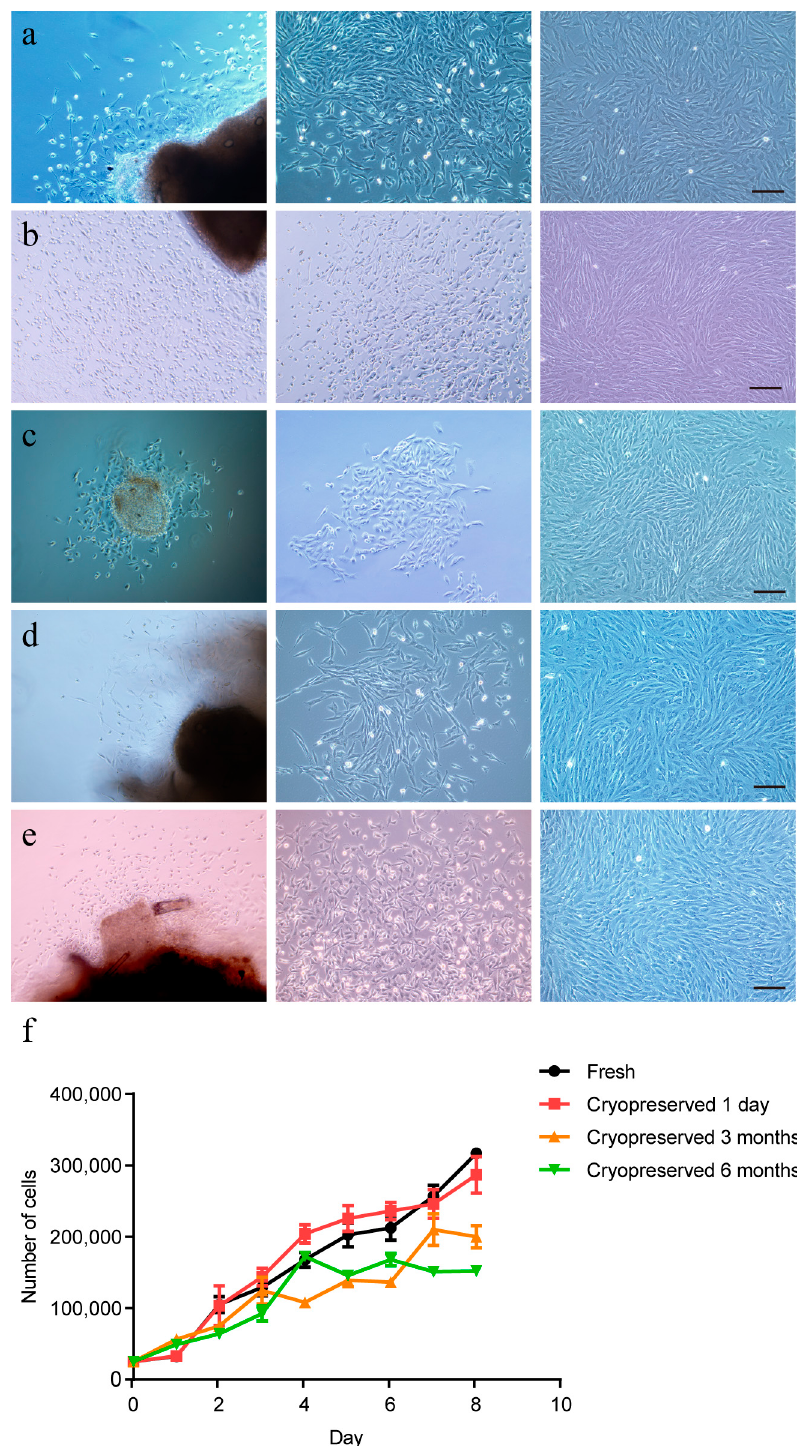
Figure 6. Effects of cryopreserved time on the vitrification of ear tissues. Viable cells isolated from porcine ear tissues cryopreserved for ( a ) 1 day, ( b ) 1 week, ( c ) 1 month, ( d ) 3 months and ( e ) 6 months. ( f ) Cell growth curves for the cells isolated from fresh tissues and frozen-thawed tissues cryopreserved for 1 day, 3 months and 6 months. The error bars represent the SEM. Scale bar = 200 µm.